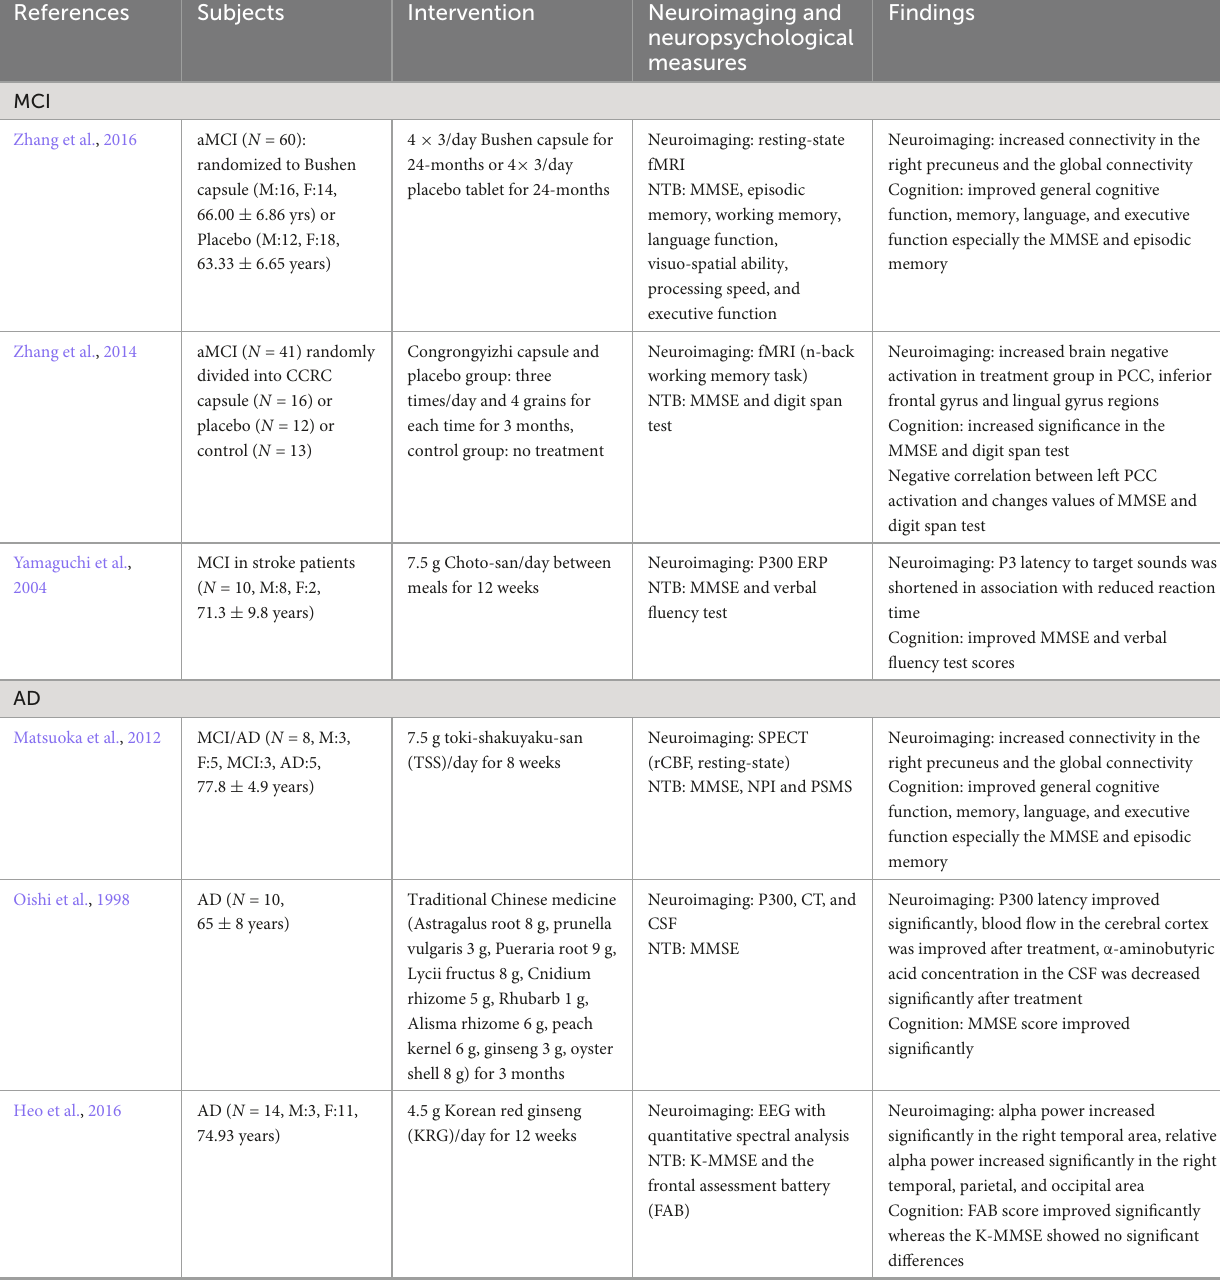
TABLE 3 Neuroimaging biomarker studies for herbal medicine treatment based on peripheral compartment in cognitive impairment